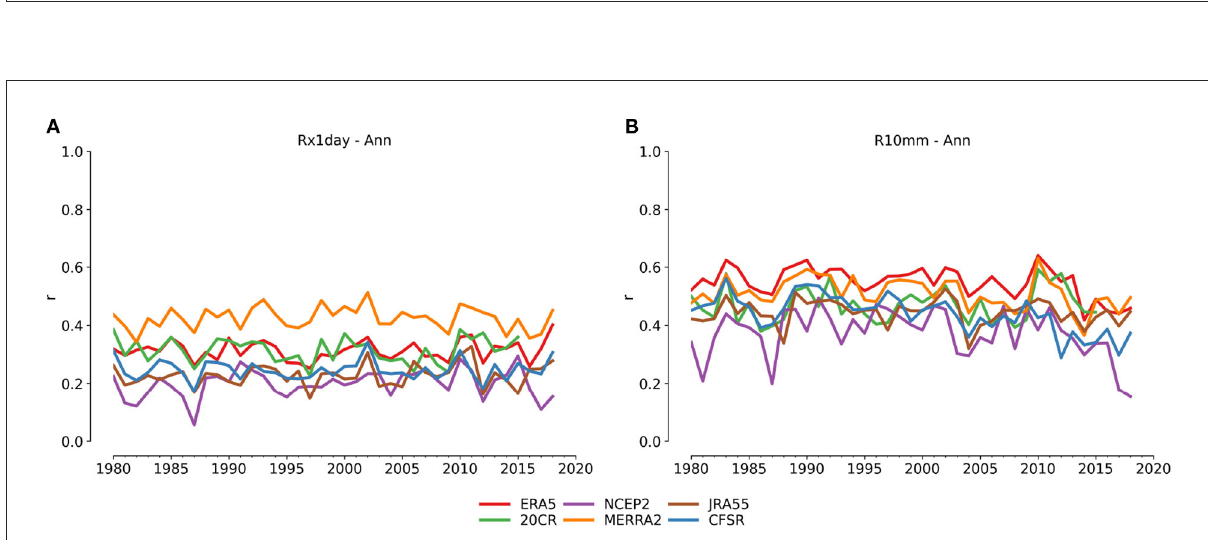
FIGURE7 Spatial rank correlation of the coverage-matched reanalyses datasets against HadEX3 for (A) Rx1day and (B) R10mm annual indices.